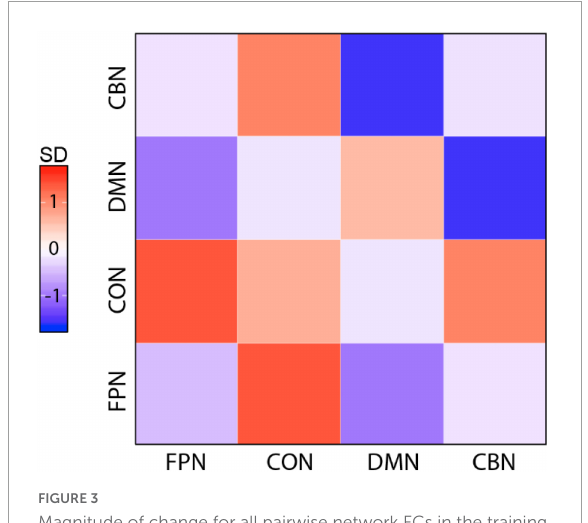
FIGURE3 Magnitude of change for all pairwise network FCs in the training group. Magnitude of change is colored by SDs from the mean calculated across all pairs and both groups. Overall, the training group showed a tendency toward increased FC of CON and decreased FC of other three networks compared with the control group (FPN, fronto-parietal network; CON, cingulo-opercular network; DMN, default mode network; CBN, cerebellar